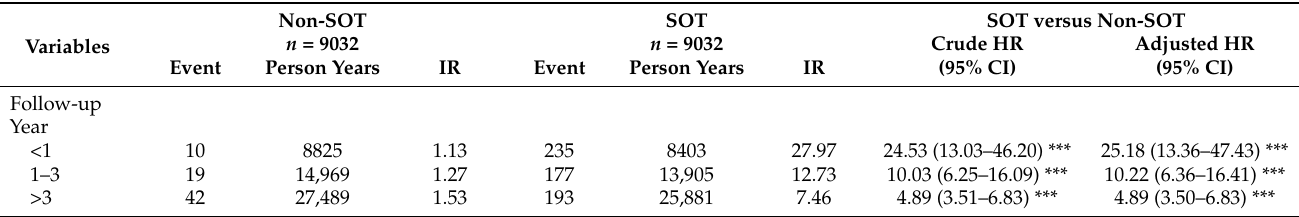
Table 4. Incidence and hazard ratio of aHV stratified by follow-up year.